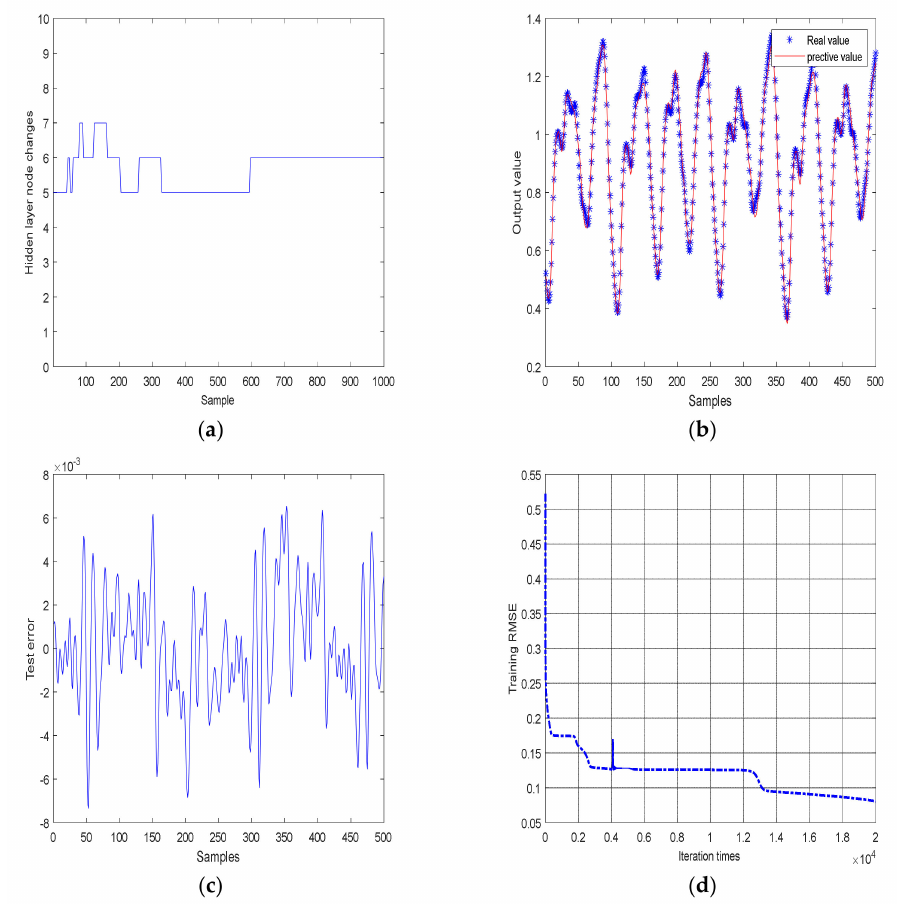
Figure 3. Prediction results of the RBFNN-GP in example B: ( a ) Number of neurons; ( b ) Fitting results of the RBFNN-GP in example B; ( c ) Test output error value; ( d ) The training RMSE value in example